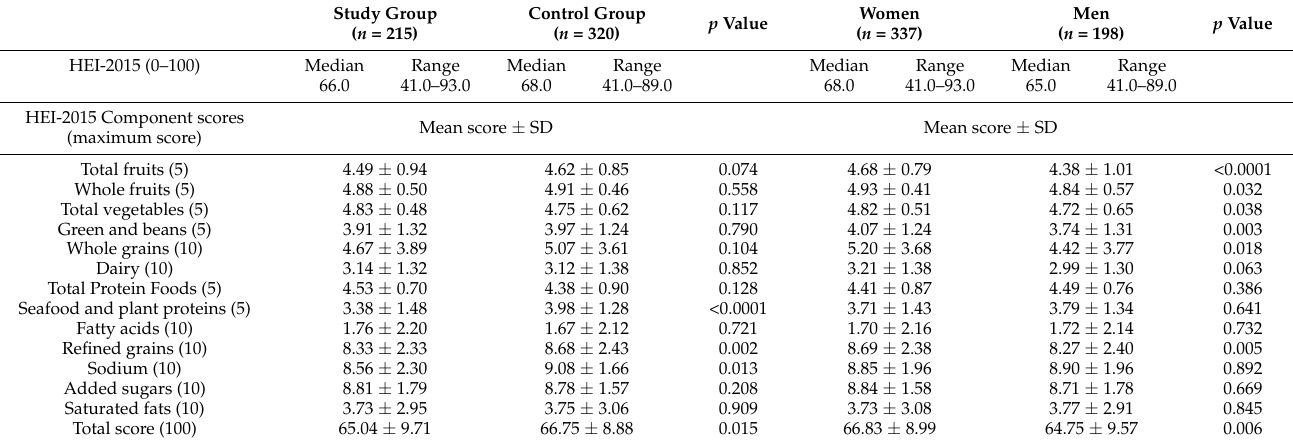
Table 3. HEI-2015 components scores for study group and control group (mean and standard